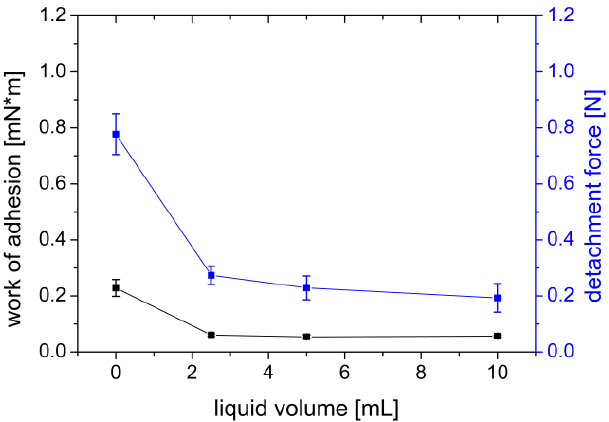
Figure 7. Effect of adding wetting liquid (PBS buffer pH 7.4) of a gel of 2% agar and 4% mucin on work of adhesion (mN × m) and detachment force (N) measured with a PVA film. Mean ± SD, n = 6.